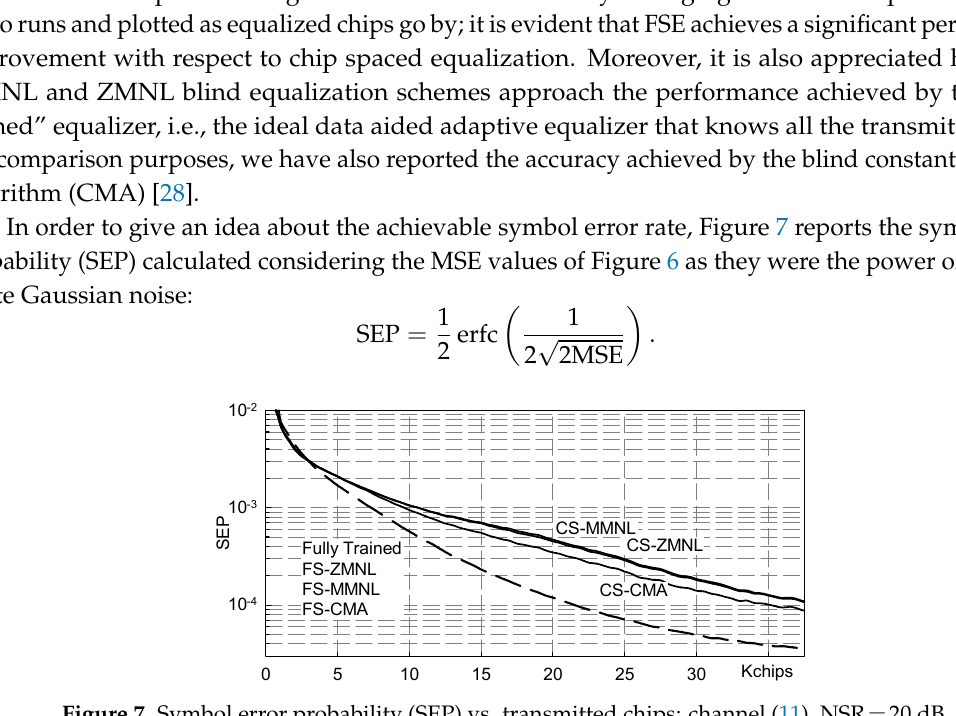
Figure 7. Symbol error probability (SEP) vs. transmitted chips: channel (11), NSR = 20